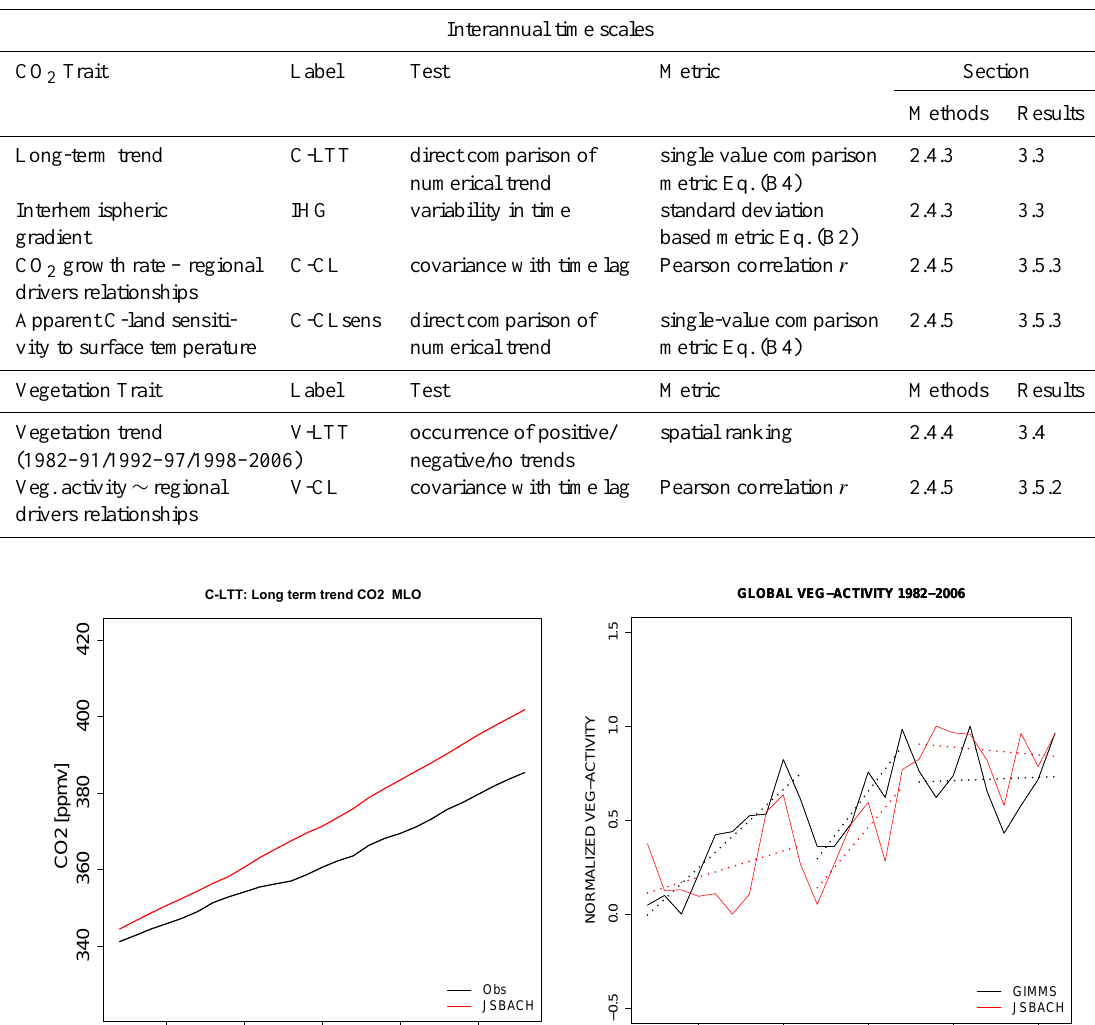
Table 3. List of atmospheric CO 2 and vegetation activity traits used for the analyses at the interannual time scale (higher than annual frequency). A detailed explanation of metrics can be found in Sect. 2 and Appendices B and C).